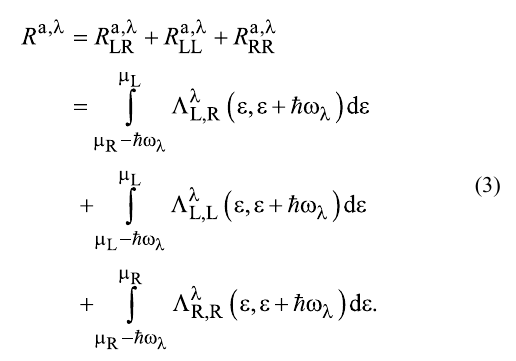
Figure 1e. The energies ε m and ε a represent the molecular and adsorbate states, respectively. The adsorbate state is pinned to the left chemical potential μ L . Black curves represent the left- and right-projected molecular DOS while the gray curve is the DOS of the